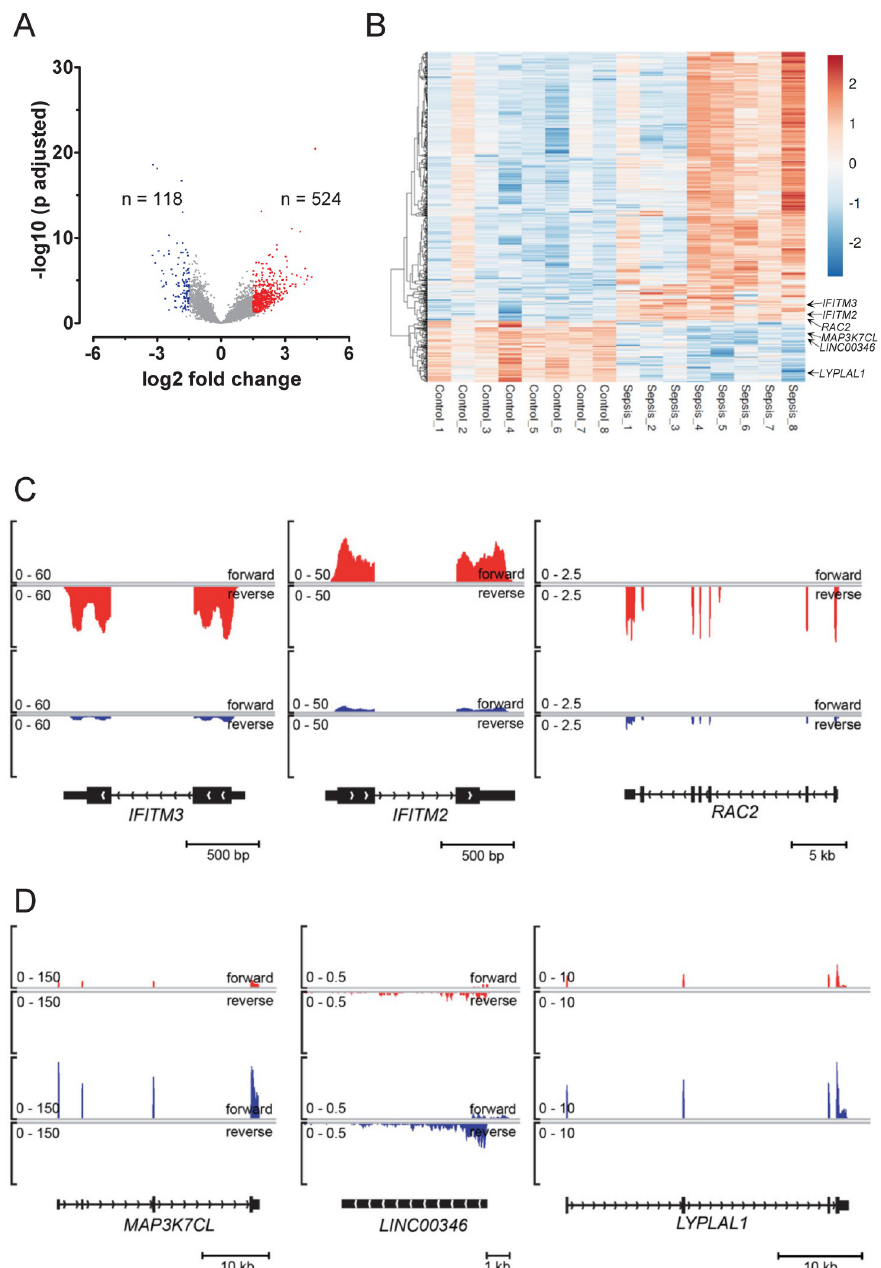
Fig 5. Differential gene expression in platelets from patients with sepsis. (A) Volcano plot of differential gene expression analysis by DESeq2. Blue dots indicate 118 downregulated genes; red dots 524 upregulated genes. Dots in light gray represent genes without significant regulation. (B) Differential gene expression illustrated by a heatmap with transcript clustering. Normalized gene expression is represented between dark red for higher expression and dark blue for lower expression than the average. Position of representative consistently expressed genes are indicated by arrows. (C) Genome Browser views of representative, upregulated genes IFITM2 , IFITM3 and RAC2 . (D) Genome Browser views of representative, downregulated genes MAP3K7CL , LINC000346 and LYPLAL1 . Scaling in black brackets indicates fragments per kilobase per million mapped reads (FPKM); merged expression of all samples in each group is shown. lincRNA = long intergenic non-coding RNA, bp = base pair, kb = kilo base pair.